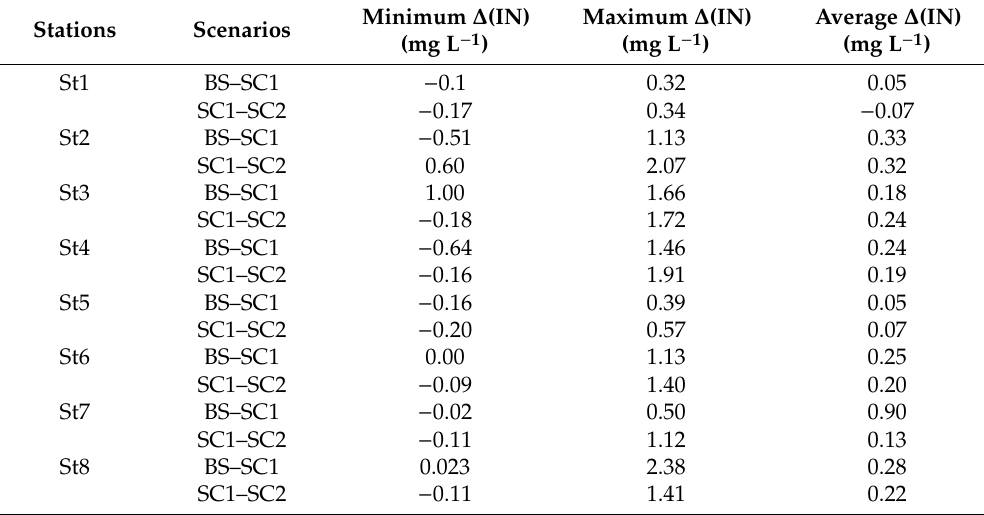
Figure 8. Snapshots of surface temperature ( ◦ C) for BS ( a ), SC1 ( b ), and SC2 ( c ), for two instants: 1— high tide, flooding at the lagoon mouth and ebbing at the mouth of the rivers (17 / 9 / 2000); 2—high tide, ebbing at the lagoon mouth and flooding at the mouth of the rivers (27 / 9 / 2000). Table 6. Inorganic nitrogen concentration di ff erence, ∆ (IN), metrics for BS–SC1 and SC1–SC2, and the lagoon stations